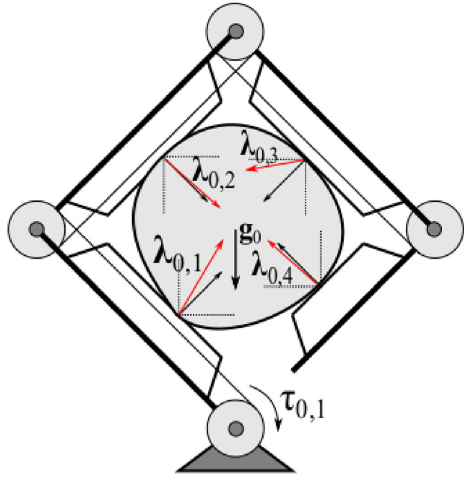
Fig. 2 Example of a single compliant underactuated robotic arm grasping an object through four contact points. Reprinted from